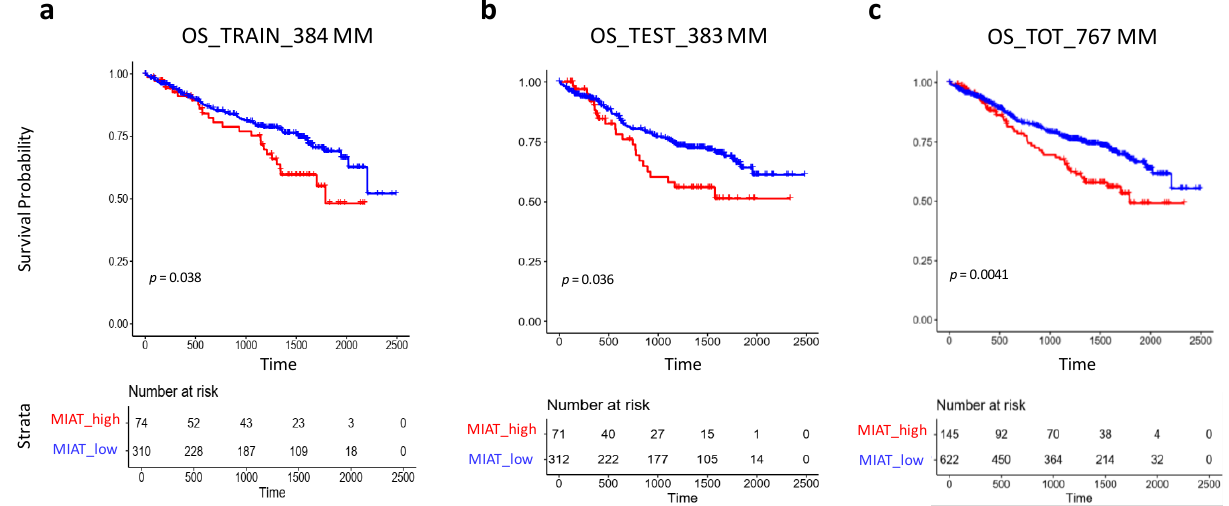
Figure 2. Kaplan–Meier survival curves in 384 MM train ( a ) and 383 MM test ( b ) sets that were randomly selected from total 767 MM dataset. MM cases were stratified in high and low MIAT expression groups, accordingly to max-stat cut-off identified in the train set with respect to Overall Survival (OS) data. ( c ) Kaplan–Meier survival curve based on the same threshold in 767 global dataset: OS median follow-up time: not reached for low group, 1789 days for high group; median follow-up time of the study 1429 days; Inter Quartile Range (IQR): [796; 1718]. Log-rank test p -values measuring the global difference between survival curves and number of samples at risk in each group across time are reported.